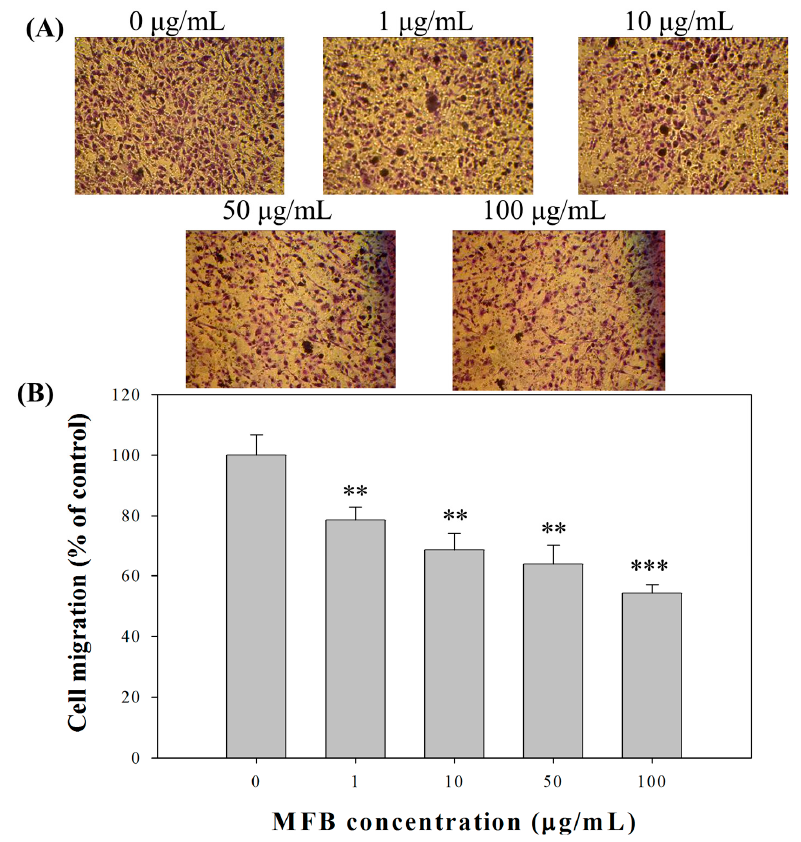
Figure 4. Effects of MFB on cell migration of SK-Hep-1 cells. Cells (5 × 10 4 ) were incubated with MFB (1–100 µg/mL) for 24 h. Representative phase contrast photomicrographs (100× magnification) were taken at 5 h ( A ) and migration ability was quantified ( B ) by counting the number of cells that invaded to the underside of the membrane. Values are means ± SD, n = 3; significant difference from control value was indicated ** p < 0.01, and *** p < 0.001.